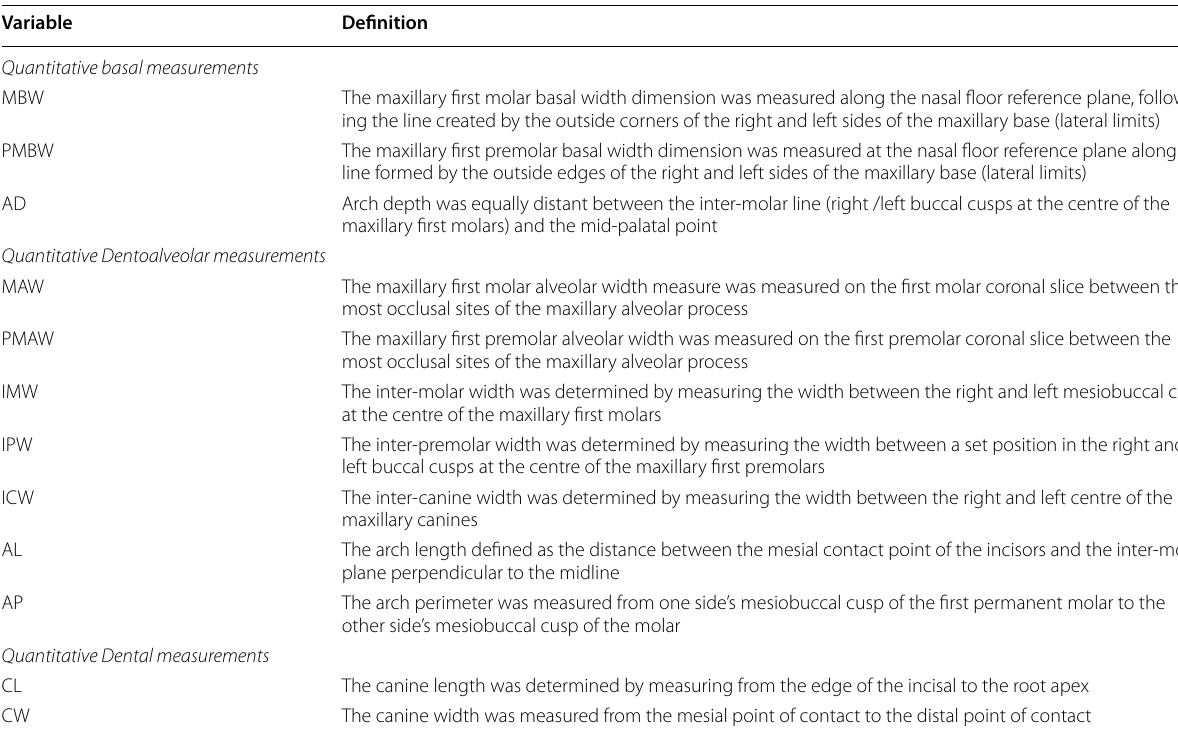
Table 2 Definitions of the measurements used in the study Variable Definition Quantitative basal